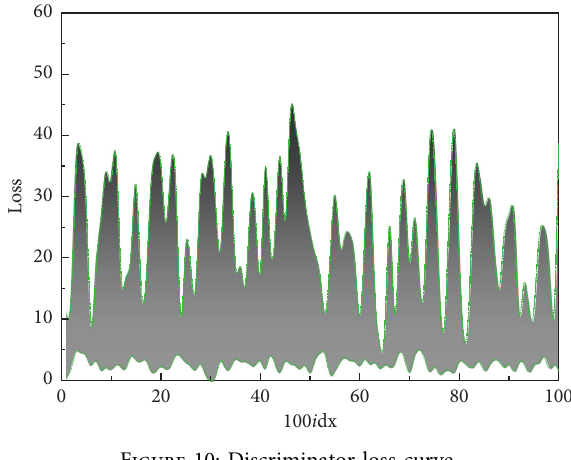
Figure 10: Discriminator loss